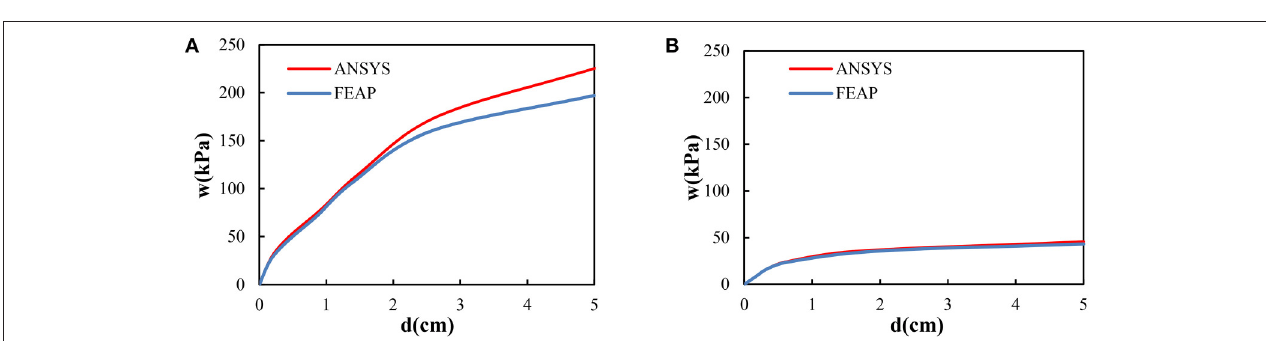
FIGURE 12 | Load vs. displacement curve at the midspan of triangular slab with a